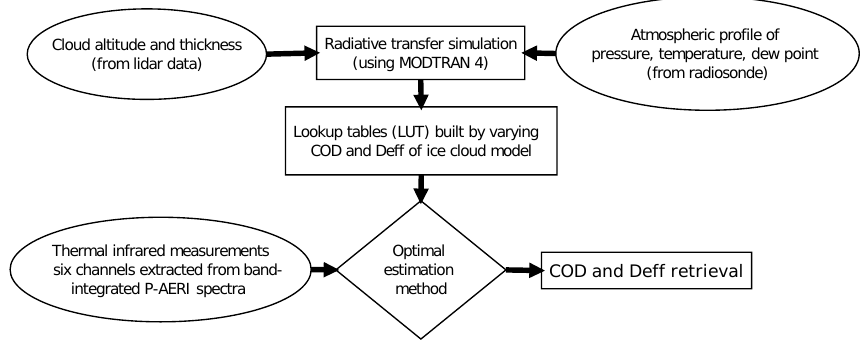
Figure 5. Flow chart of the retrieval